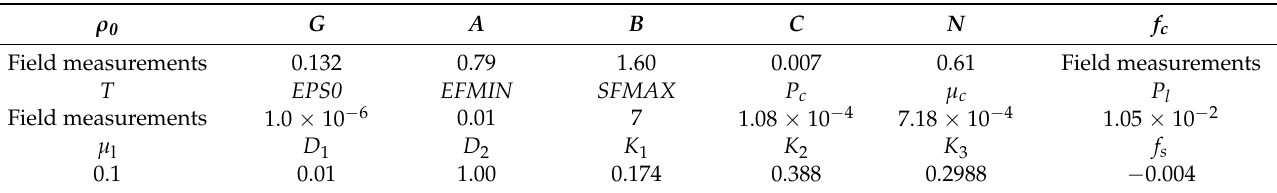
Table 1. JHC model parameters of rock mass (uint: g-cm- µ